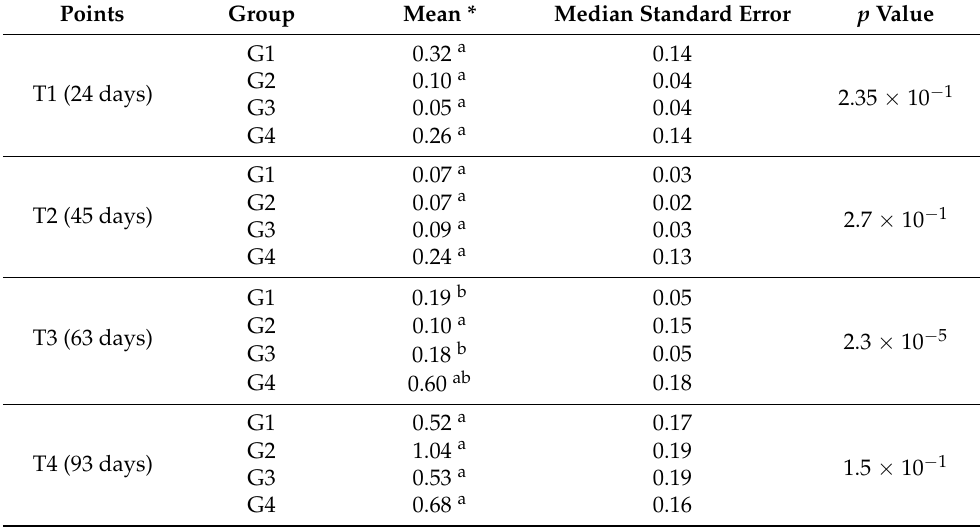
Table 1. Mean S/ P value for IgG anti-Mhyo between groups over time for each time point (T) from T1 to T6 (151 days of age for G1, G2 and G3 pigs and 145 days of age for G4